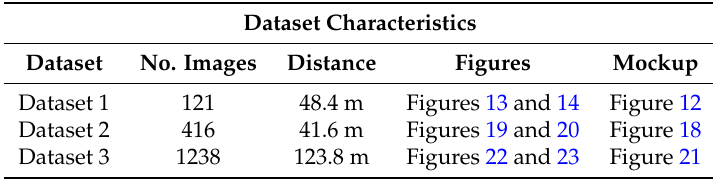
Table 1. Dataset